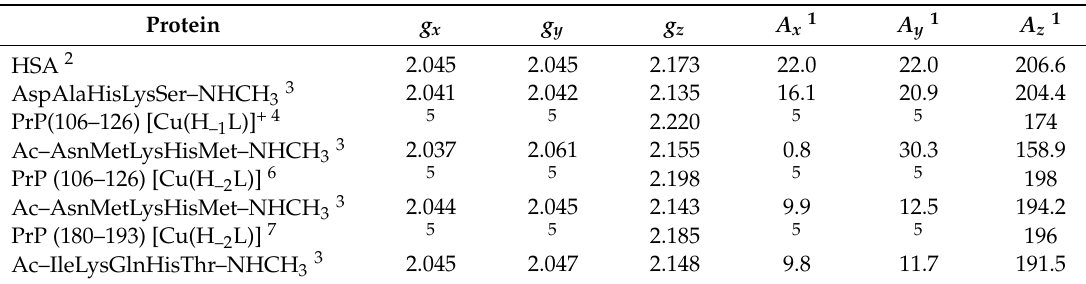
Table 4. Experimental spin Hamiltonian parameters for the interaction of Cu(II) with HSA and fragments 106–126 and 180–193 of prion protein, and comparison with the values calculated by DFT methods.